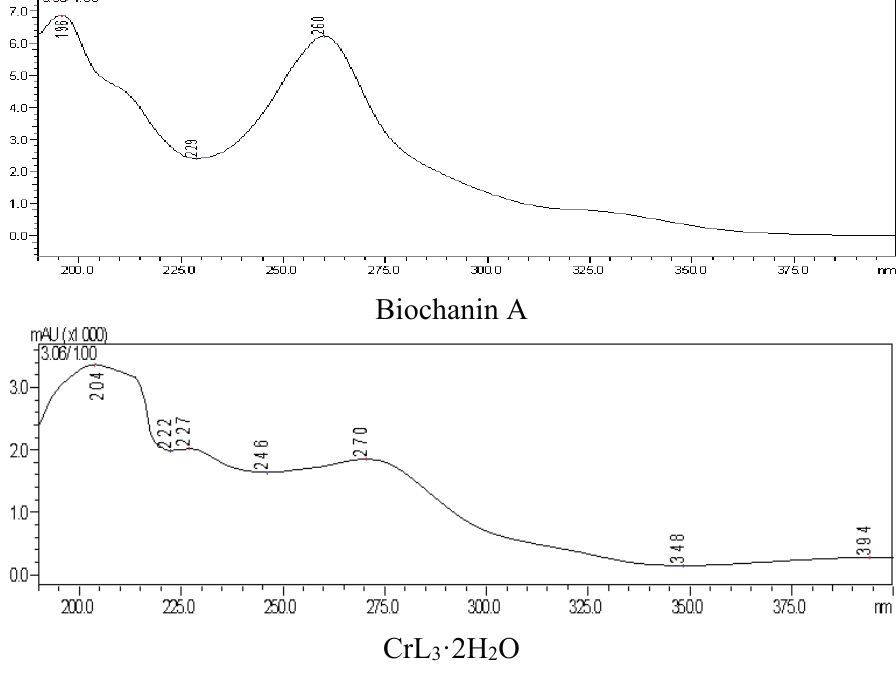
Figure 8. UV spectra